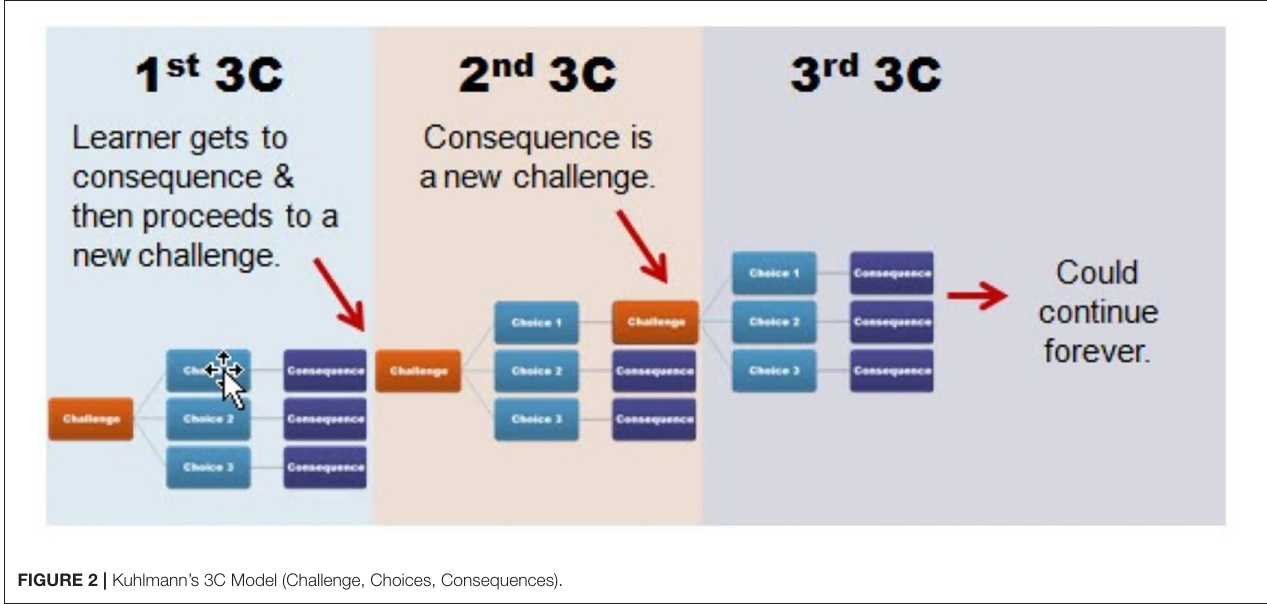
FIGURE 2 | Kuhlmann’s 3C Model (Challenge, Choices, Consequences).